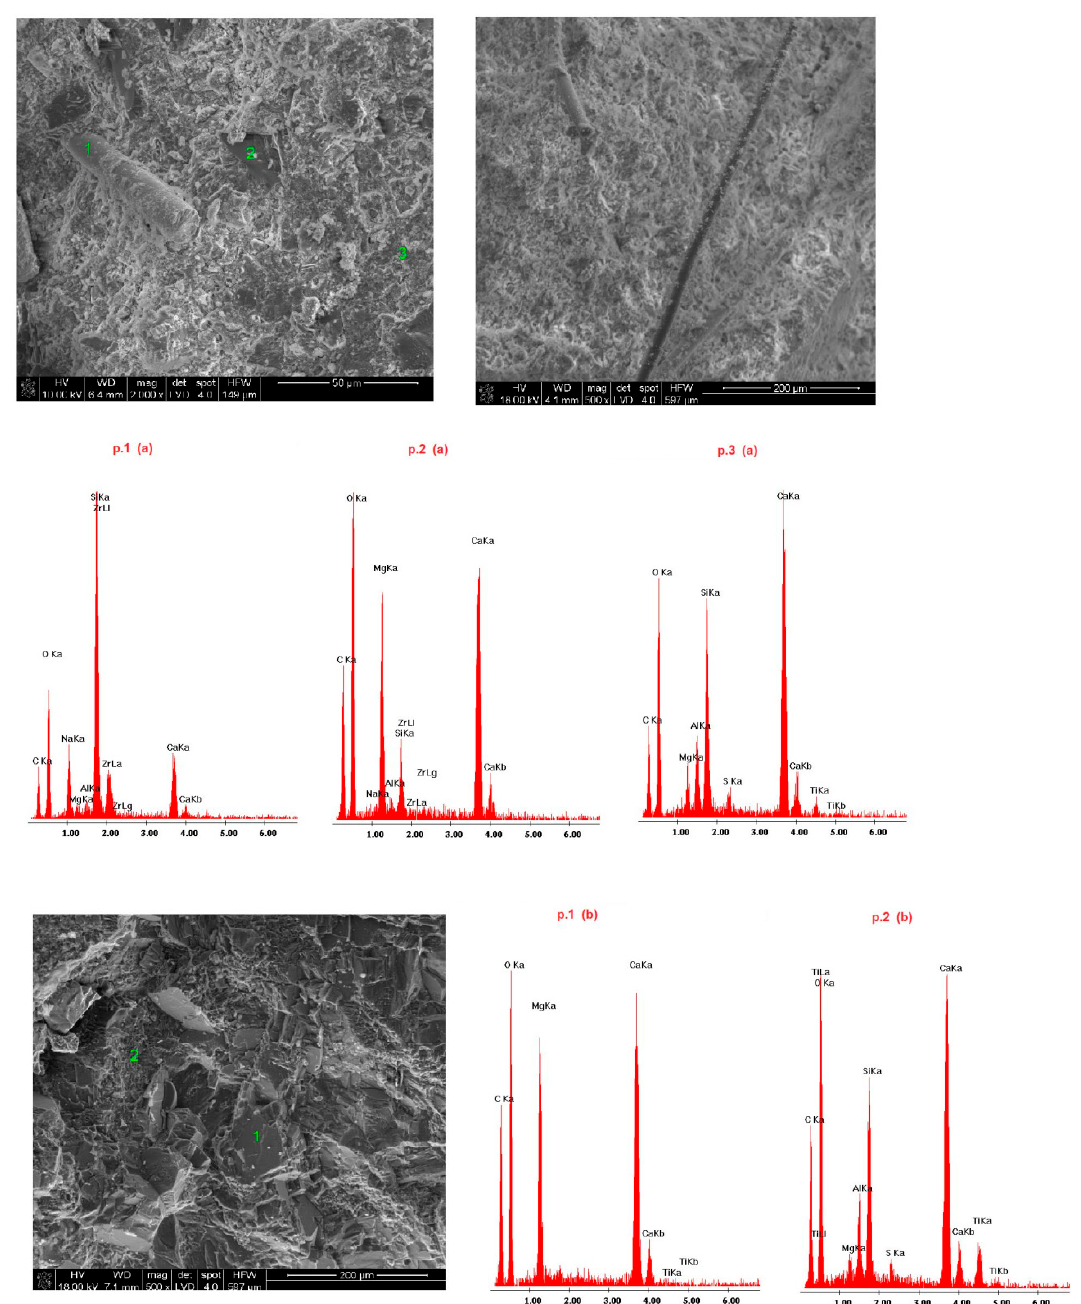
Figure 10. SEM microphotograph and EDS analysis of sample 2.